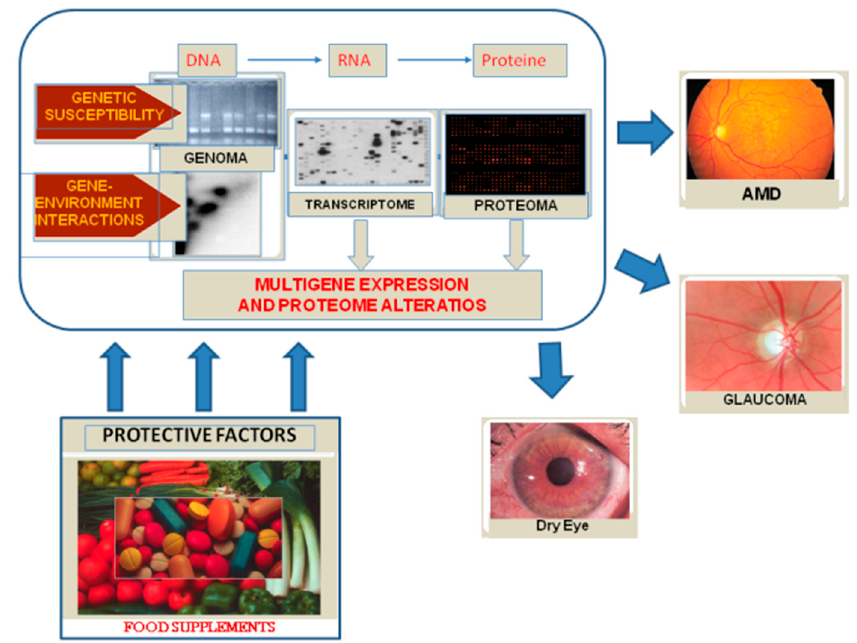
Figure 2. By interacting with genetic and environmental factors, oxidative stress results in DNA damage, alterations of gene expression and of the protein profile and, finally, disease.